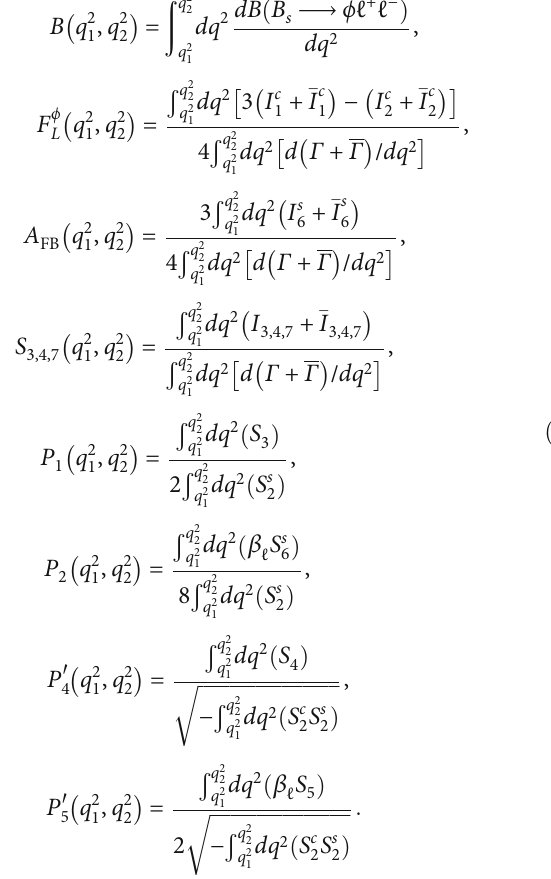
ffiffiffiffiffiffiffiffiffiffiffiffiffiffiffiffiffiffiffiffiffiffiffiffiffiffiffi